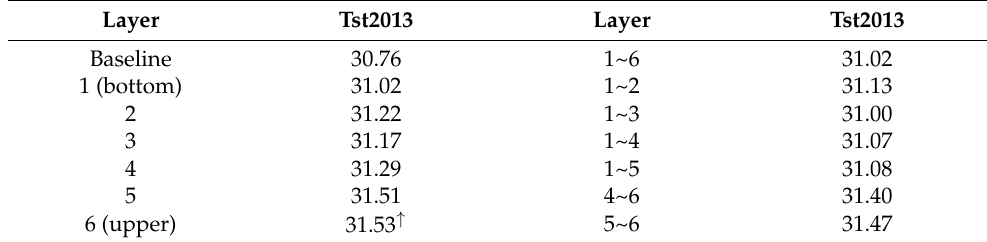
Table 4. Performance of different integration layers on the IWSLT15 En–Vi task. Layer Tst2013 Layer